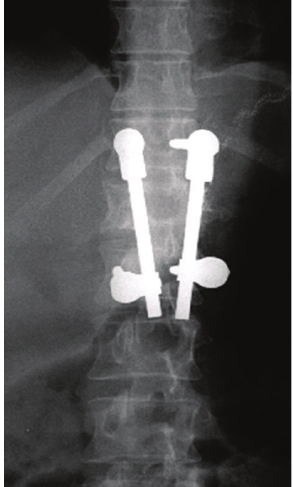
Figure 4: Postoperative AP showing view of a good reduction of the T12